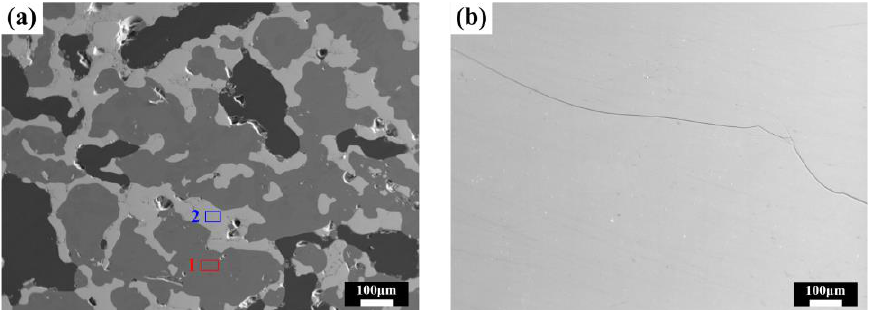
Figure 4. Typical microstructures of the quenched slags after reduction, ( a ) 1250 °C; ( b ) 1350 °C.